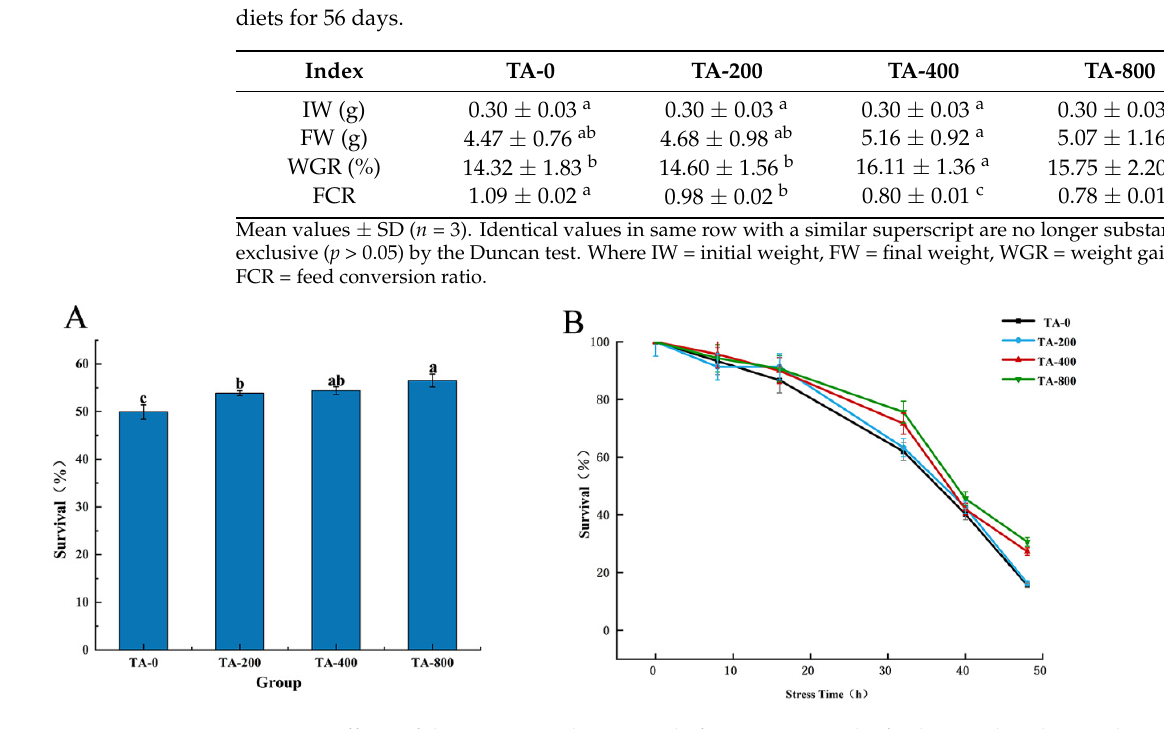
Figure 1. Effects of dietary TA on the survival of L. vannamei at the feeding trial 56 days and ammonia stress for 48 h. ( A ) The survival of shrimp fed the four experimental diets 56 days; ( B ) the survival of shrimp after ammonia stress for 48 h. Vertical bars represented the mean values ± SD ( n = 3). Data marked with different letters were significantly different ( p < 0.05) among groups.